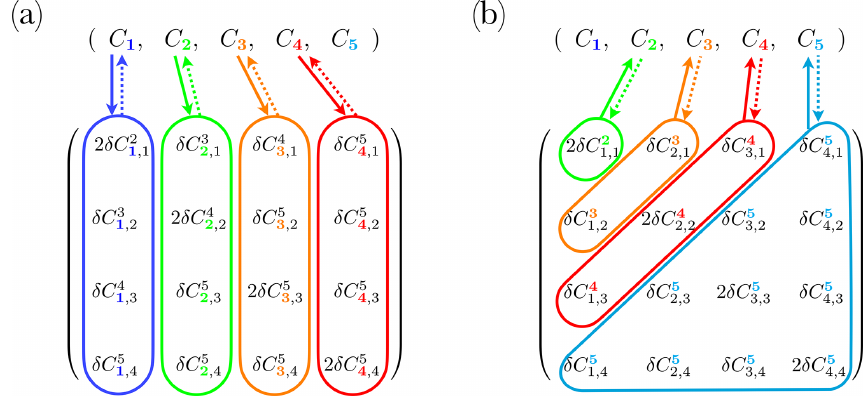
N = 6. Concentration evolution 2 N . Bottom matrices 2